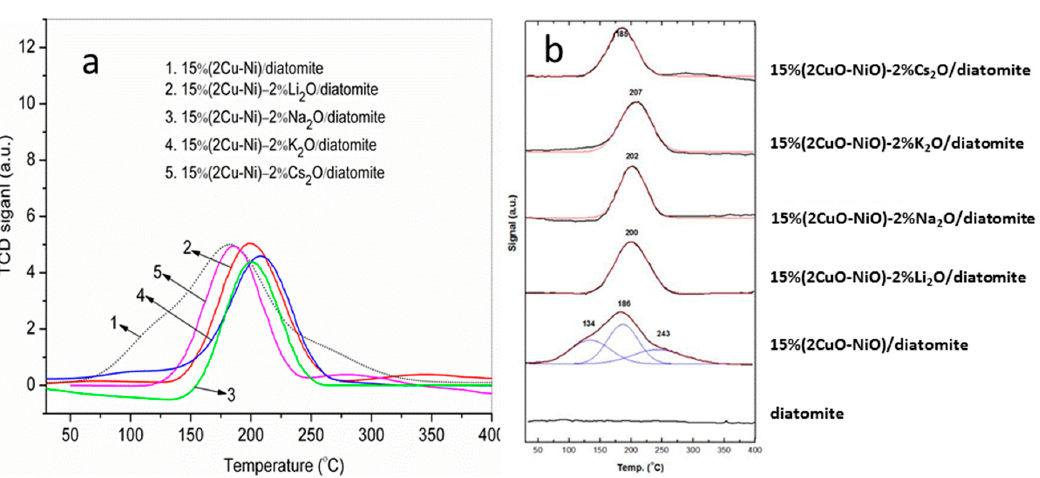
Table 3. Influence of alkali loading on catalytic performance of 15% (2Cu-Ni)/diatomite.